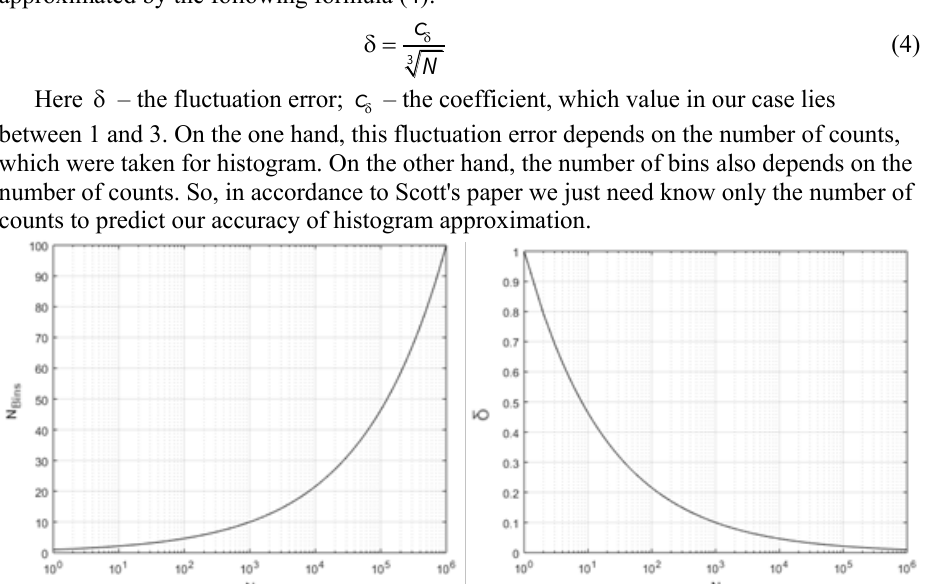
Fig. 4. The dependences    